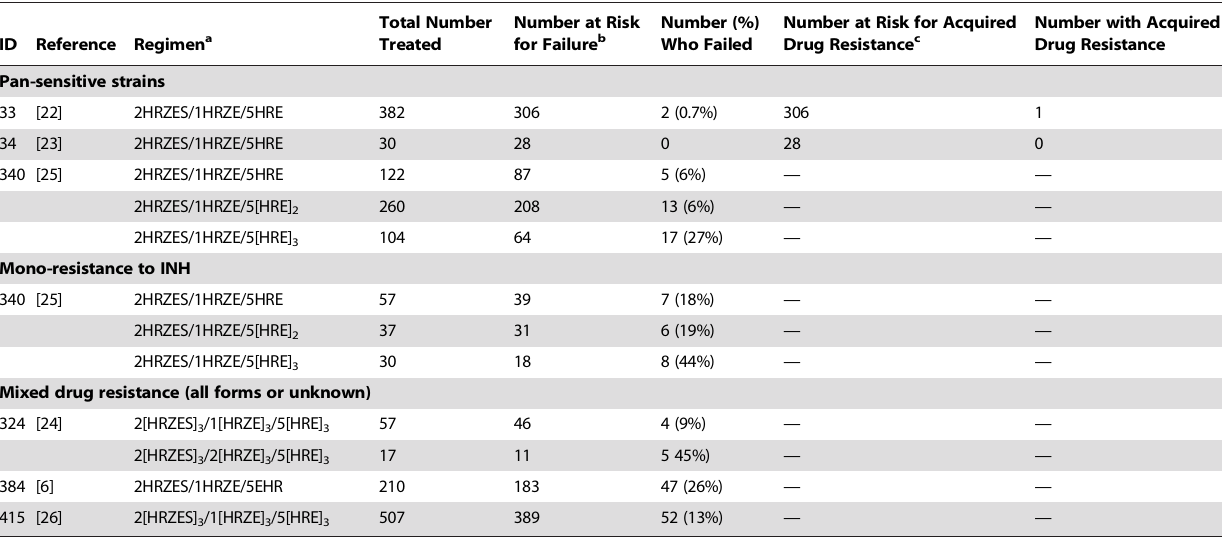
Table 1. Cohort studies reporting results with standardized retreatment regimen recommended by WHO.